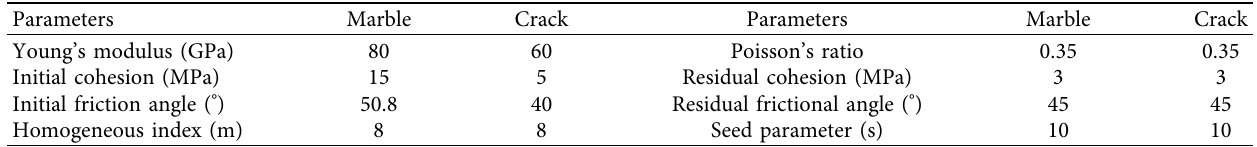
Figure 7: Numerical model of intact and precracked specimens: (a) intact specimen, (b) specimen containing single crack, (c) specimen containing multiple parallel cracks, and (d) specimen containing multiple unparallel cracks. Table 1: Parameters used in